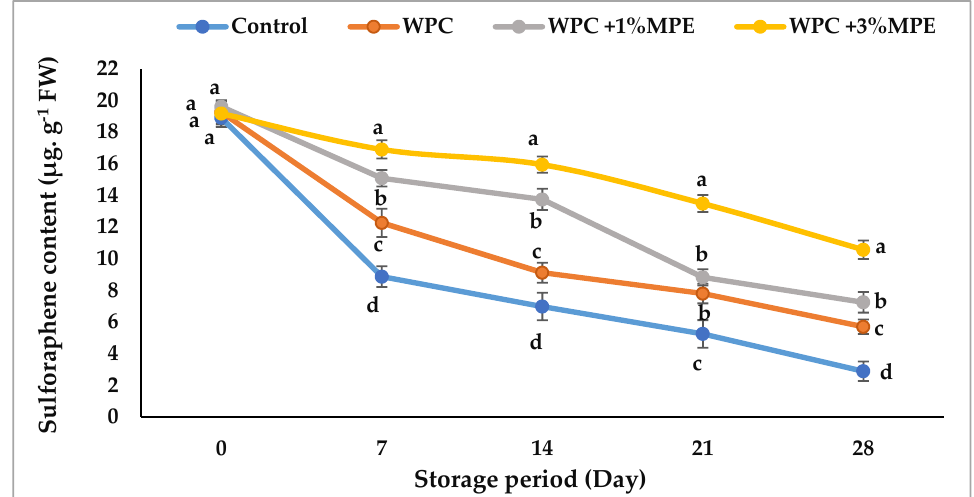
Figure 5. Effect of whey protein concentrate combined with mango peel extract (WPC = whey protein concentrate alone, WPC + 1% MPE = whey protein concentrate + mango peel extract at 1% and WPC + 3% MPE = whey protein concentrate + mango peel extract at 3%) on sulforaphene content of broccoli fresh-cuts at 5 °C. Vertical bars indicate standard deviation (n = 6). Means and different letters indicate significant difference between treated and control broccoli for each storage period (Duncan’s multiple range test at 95%).